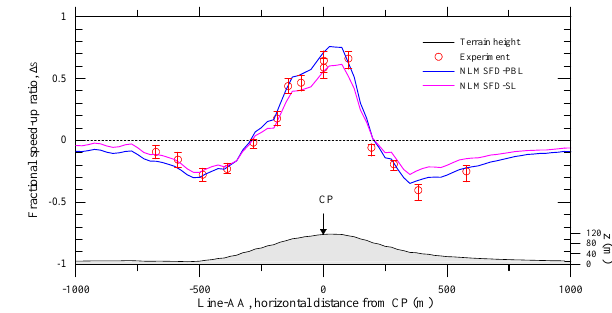
Figure 3. Computational domain of the Askervein hill and measurements twoer along the A-line, AA-line and B-line.